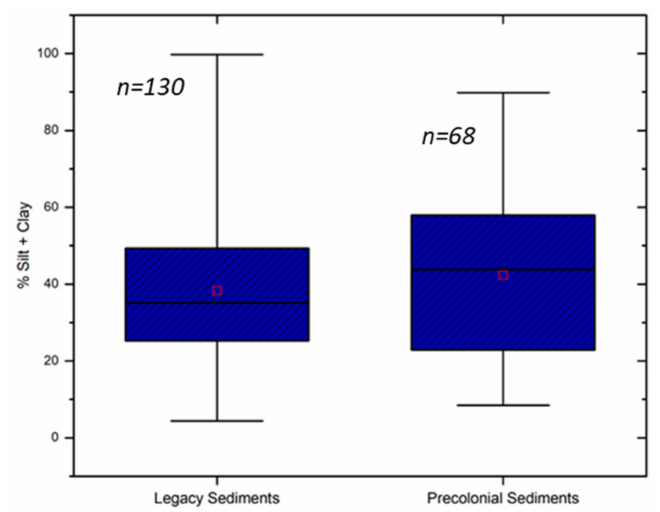
Figure 9. Comparison of the fine-grained sediment content of the precolonial and legacy sediments along entrenched alluvial channels. Box represents 25–75% of samples; horizontal line is the mean; small square is median; whiskers represent maximum and minimum